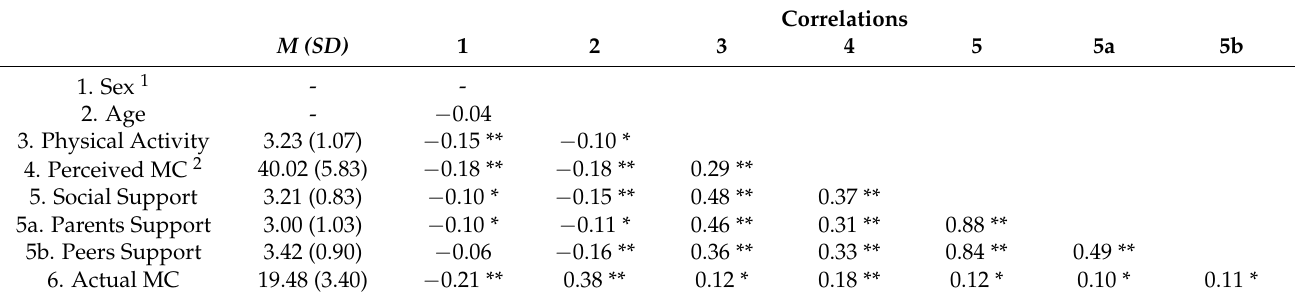
Table 1. Descriptive statistics and correlations between study